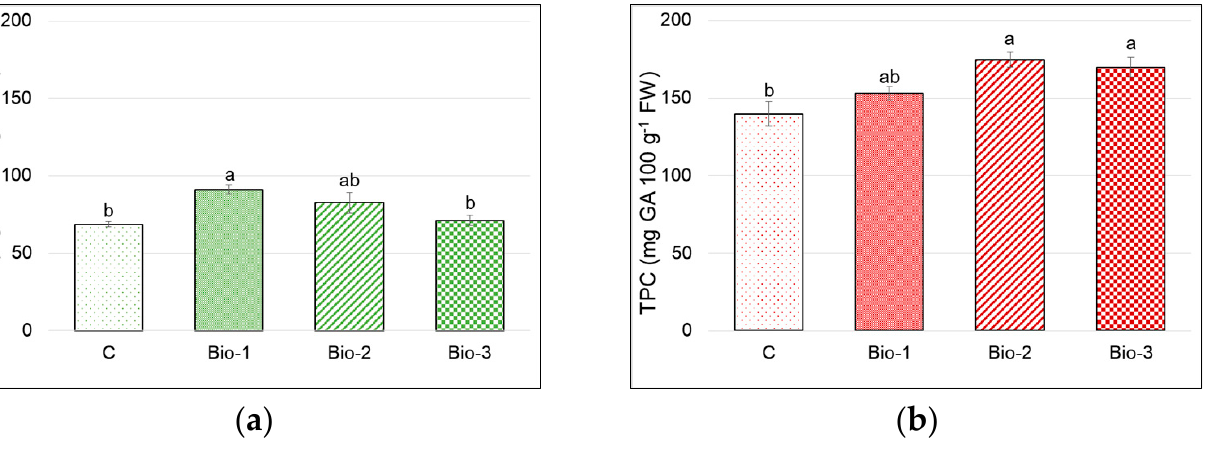
Figure 5. Effect of biostimulants (Bio-1 = TRAINER ® ; Bio-2 = AQUAMIN, and Bio-3 = Moringa oleifera leaf extract) on total phenols content (TPC) (mg GA 100 g − 1 FW) in turnip greens ( a ) and radish ( b ) microgreens. Data are means ± se ( n = 3). Different letters indicate significance at p ≤ 0.05 according to the LSD test.